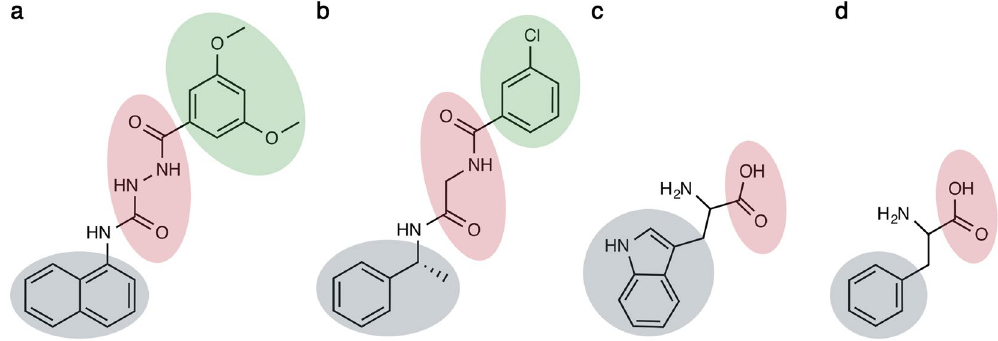
Figure 1. Structure of the GPR139 agonists studied herein. ( a ) Surrogate agonist 1a from Shi et al . 23 . ( b ) Surrogate agonist 7c from Dvorak et al . 14, 24 . ( c , d ) Trp and Phe from Isberg et al . 16 . Coloring denote chemical commonalities (supported by mutations herein); grey: major hydrophobic part, red: polar linkers ( 1a and 7c ) or carboxyls ( Phe and Trp ), green: hydrophobic element unique for the larger 1a and 7c